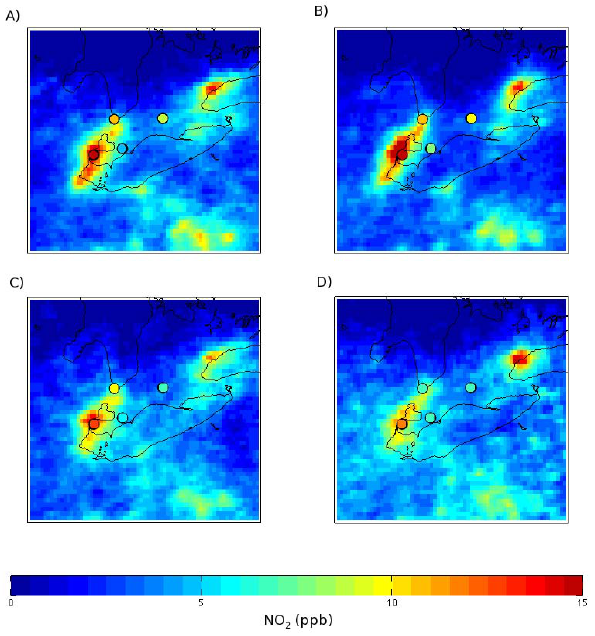
Fig. 12. OMI inferred NO 2 concentrations for 2007 grouped by surface wind direction as measured at Windsor. (A) represents only OMI measurements taken when wind was blowing from the NW direction. ( B , C and D ) Same as (A) but NE, SW and SE directions, respectively. NW coast of Lake St. Clair indicated by black ar- row in (D) ; inferred concentrations over the lake are approximately half those onshore when the lake is upwind of the onshore emis- sions sources (i.e. when the wind blows from the SE). Number of overpasses used to generate each average was 21 (21% of available overpasses) for (A) , 70 for (B) , 98 for (C) and 48 for (D) . The total number of overpasses used is less than the total number of days in the year because of rejection of overpasses for which > 2 surface stations were occluded by